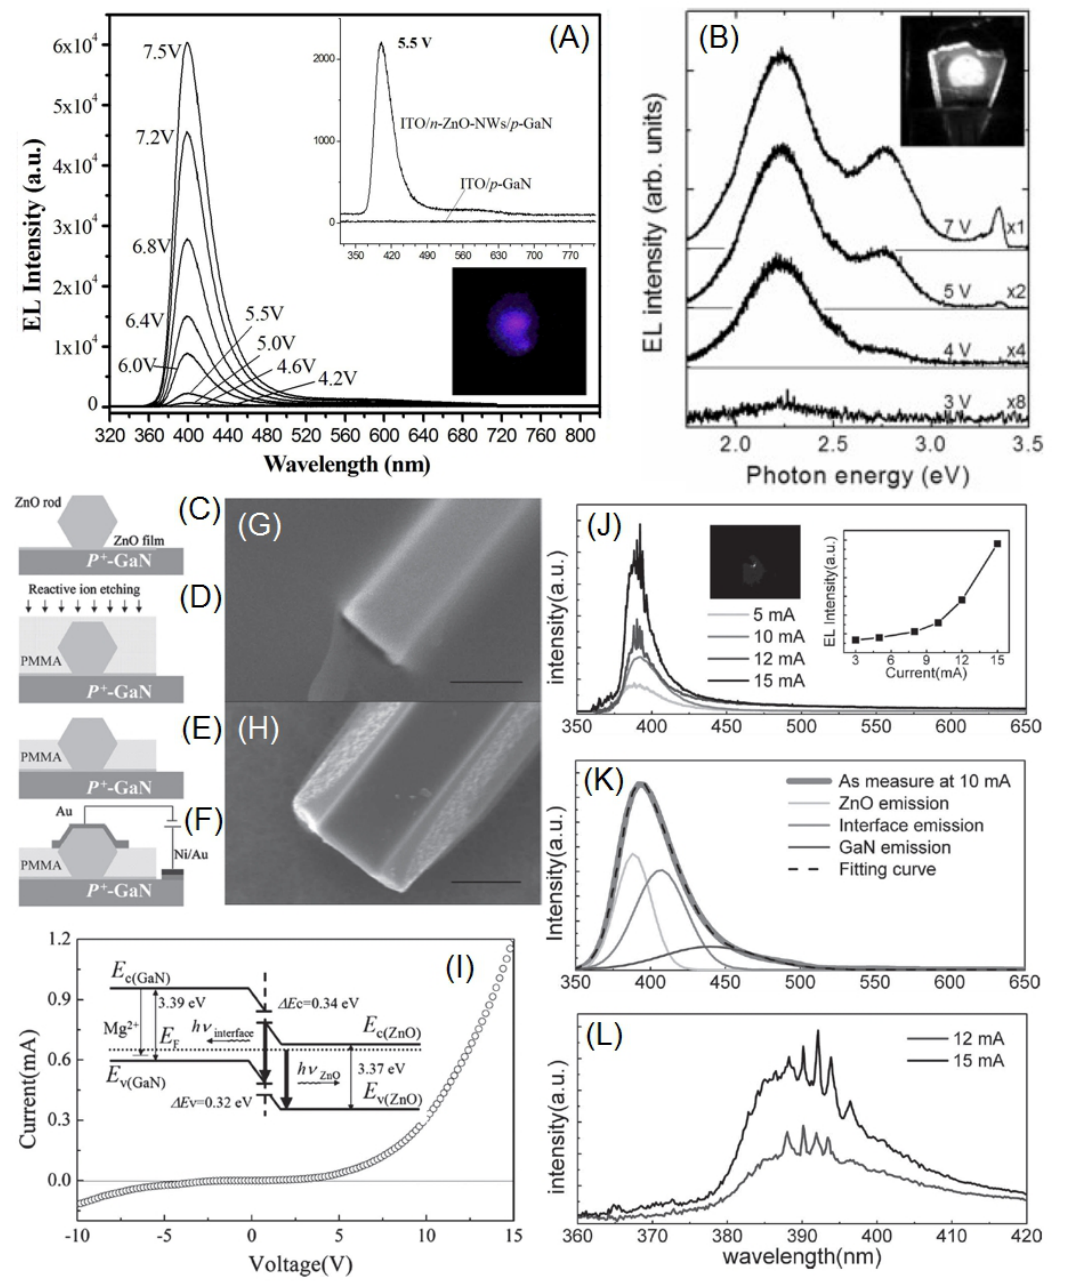
Figure 15: (A) Room temperature EL spectra of the ITO/ZnO-nanowires/p-GaN/In–Ga heterojunction under different forward bias voltages. Inset (top right) shows the comparison of EL spectra from the heterojunction structure and an ITO/GaN/In–Ga structure. Inset (bottom right) is an image of the light emission spot under a dc bias of 6 V at room temperature. (B) EL spectra of a n-ZnO nanorods/p-GaN device by reverse-bias voltage. Inset is a photograph of light emission from the EL device at a bias voltage of 5 V. (C–F) The fabrication process of a ZnO microrod/GaN heterojunction. (G, H) SEM image of the ZnO microrod covered by a PMMA thin film and microrod after reactive ion etching. (I) I–V curve for the ZnO microrod/GaN heterojunction; the inset shows a schematic of the band diagram. (J) The EL spectra from the ZnO microrod/GaN heterojunction under different applied current. The left inset shows a photograph of the EL emission from sample and the right inset shows the relationship between the EL intensity with the applied current. (K) Gaussian fit of the EL spectrum under the applied current of 10 mA. (L) The enlarged spectra from 360 to 420 nm under currents equal to 12 and 15 mA. Reproduced with permission from Ref. [147] (A), [155] (B), and [159] (C–L). EL: electroluminescence; SEM: secondary electron